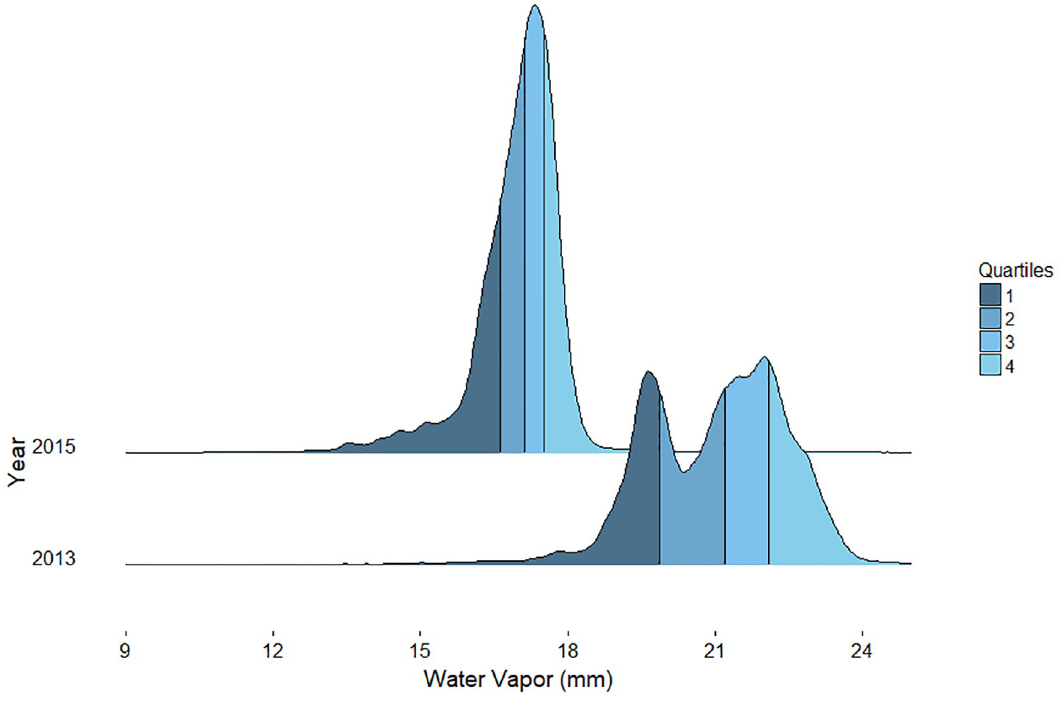
Fig 5. Water vapor distributions by